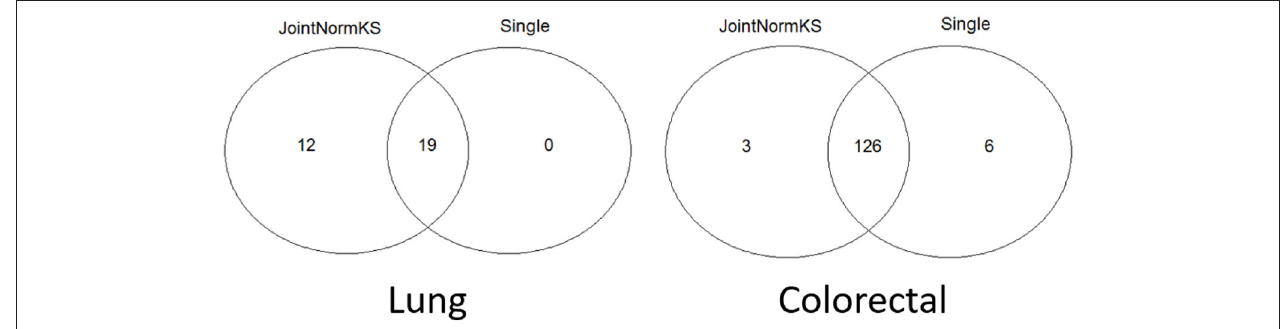
FIGURE 3 | Venn diagram of identified enriched pathways by JointNormKS and single data set analysis in lung and colorectal adenocarcinoma data sets. FDR cutoff is set to